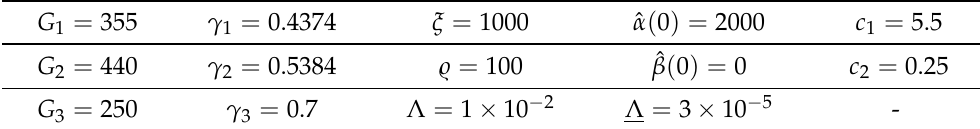
Table 2. Control parameters of